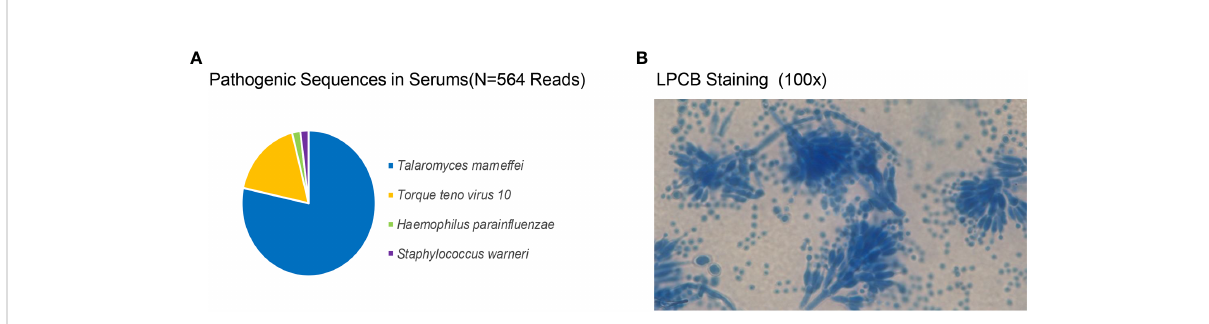
FIGURE 2 Talaromyces marneffei identi fi ed by metagenomic next-generation sequencing and Sanger sequencing. (A) The pathogen sequences ( N =